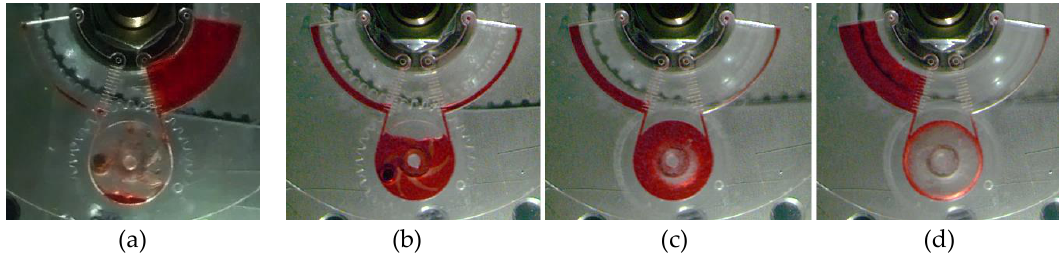
Figure 7. Microfluidic CD ( a – d ) bidirectional pumping progress, showing the liquid transferring from chamber A to B. ( a ) the initial state, ( b ) liquid transfer to pumping chamber by rotating the microfluidic CD, ( c ) activating the pump to transfer the liquid to chamber B, ( d ) complete liquid transfer to chamber B.